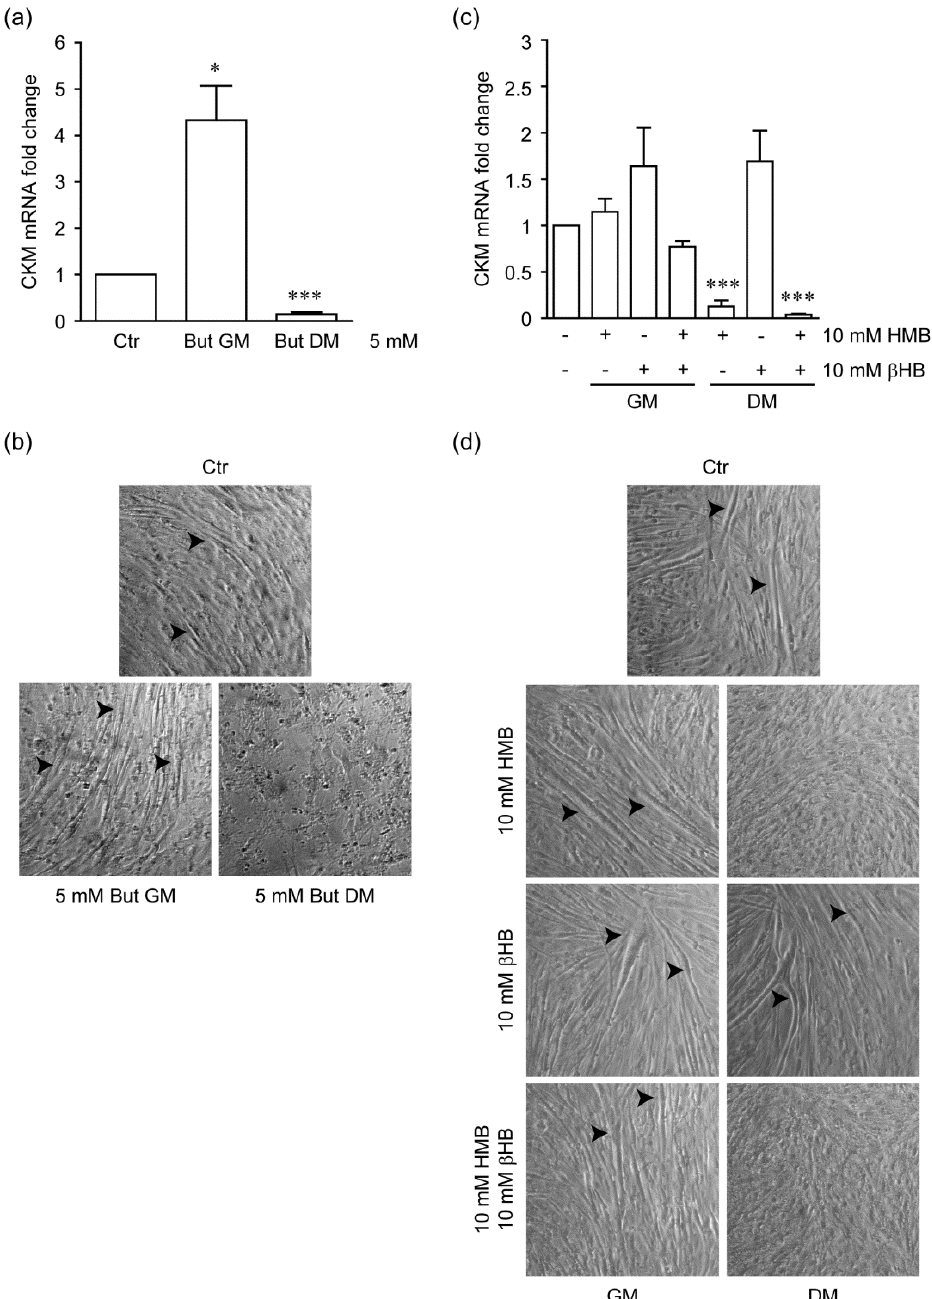
Figure 3. ( a ) Real-Time qPCR analysis of Muscle Creatine Kinase (CKM) mRNA expression in C2C12 cells exposed to Butyrate (But) at different stages of differentiation. GM: growth medium; DM: differentiation medium. Values are relative to cells undergoing the standard differentiation protocol without Butyrate (Ctr). Columns indicate mean ± SEM. * p < 0.05; *** p < 0.001 versus Ctr (